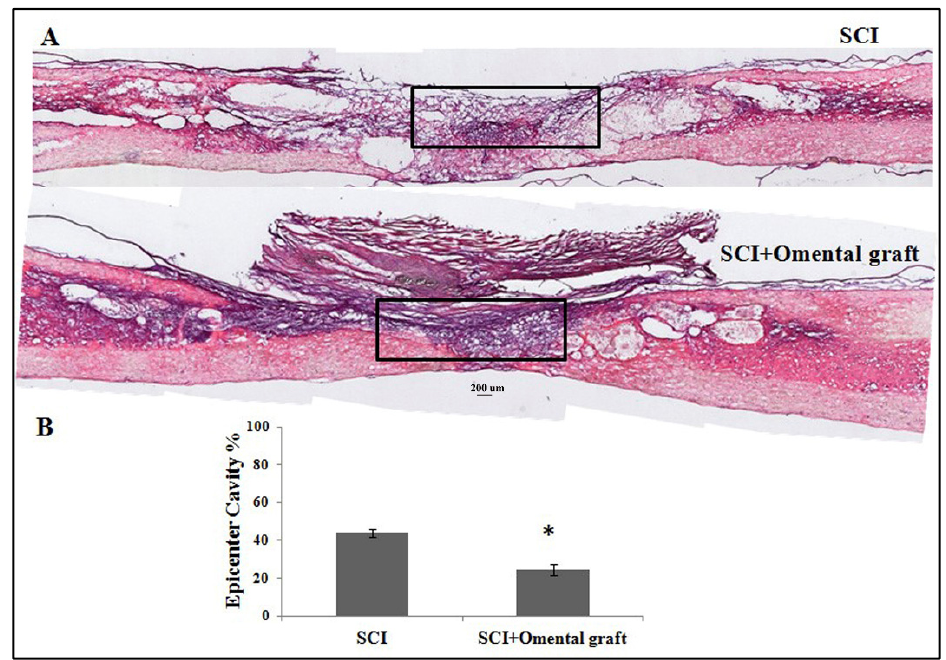
Figure 3. Hematoxylin and eosin (H&E) staining of injured thoracic spinal cords. ( A ) Representative images of longitudinal spinal cord sections in contusive SCI rats with saline or omentum graft at 6 weeks post-injury. ( B ) Quantification of cavities in the injured epicenter (calculated from a rectangle area of 1500 × 300 dpi in the injured cords (shown in A )) of contusive SCI rats with saline or omentum graft. All pixels within the rectangles were analyzed with Image J software. Data are expressed as mean value ± SEM. The cavity in contusive SCI rats with omentum graft was significantly smaller (* p < 0.05).